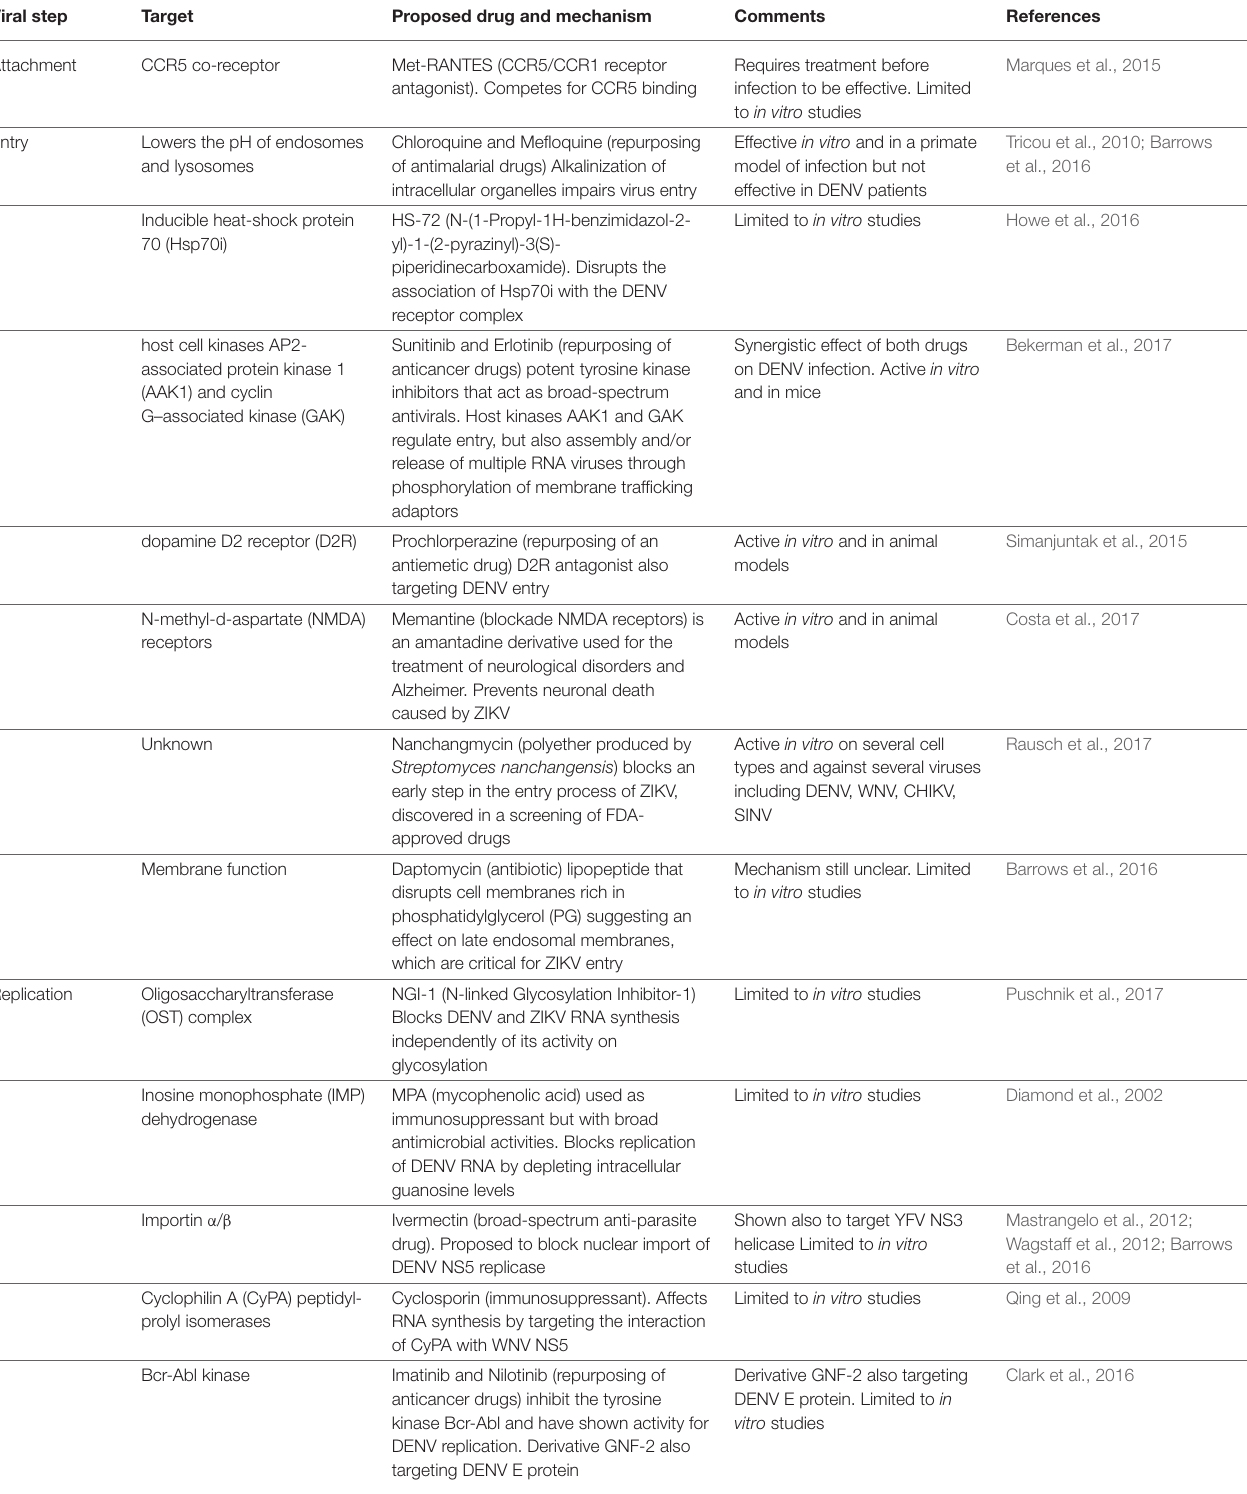
TABLE 1 | Antiviral HDT for